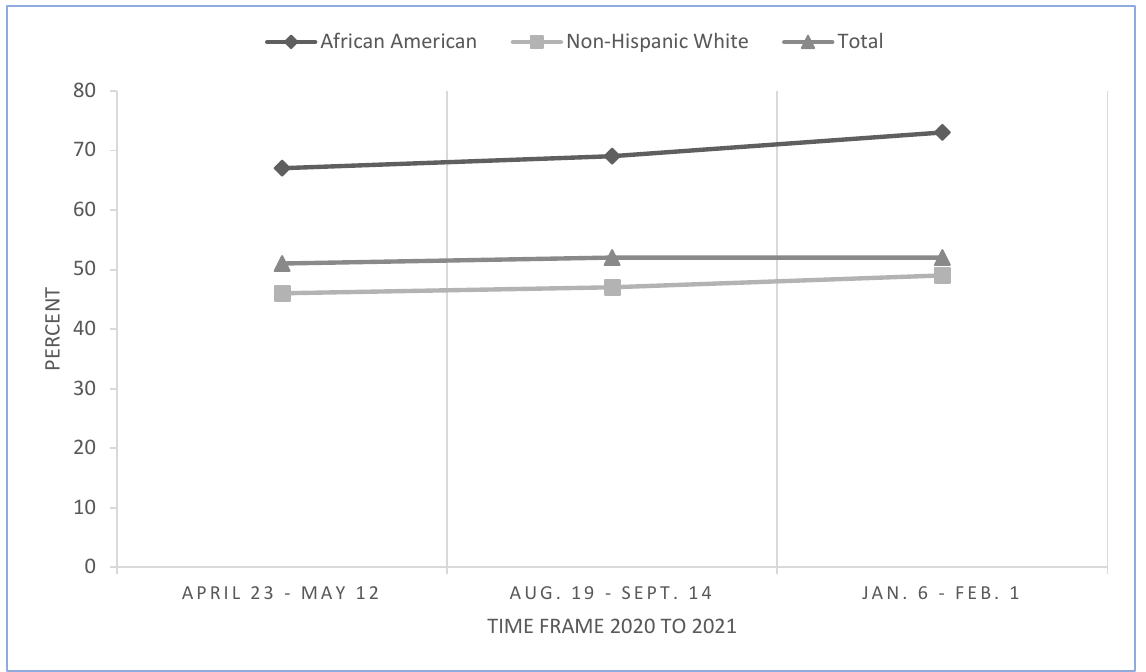
Figure 2. Households with Children That Lost Employment Income Since Start of COVID-19 in Ohio by Race